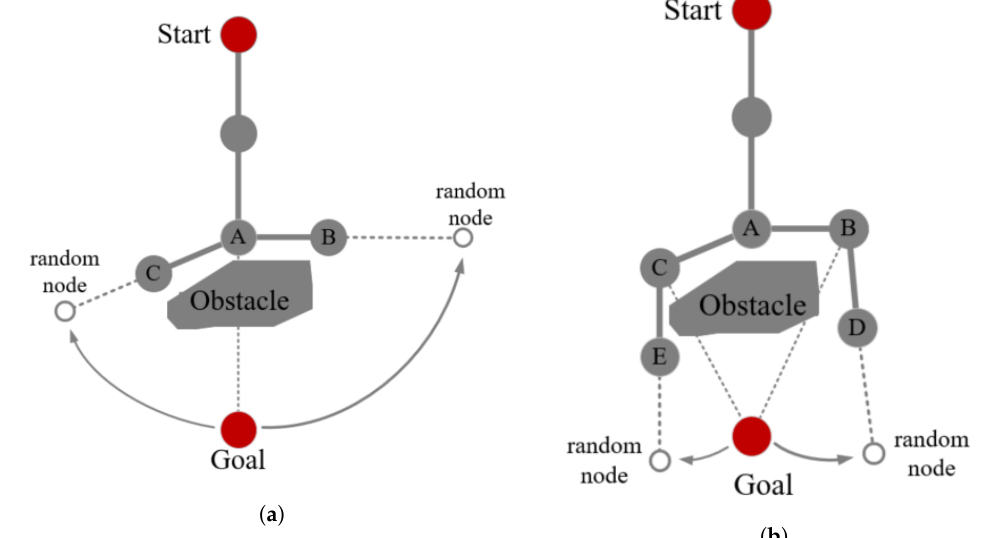
Figure 3. ( a ) shows the first branch growth. The point A is the root node, the point C and the point B are the leaf nodes; ( b ) shows the second branch growth. The point C and the point B are the root nodes, the point E and the point D are the leaf